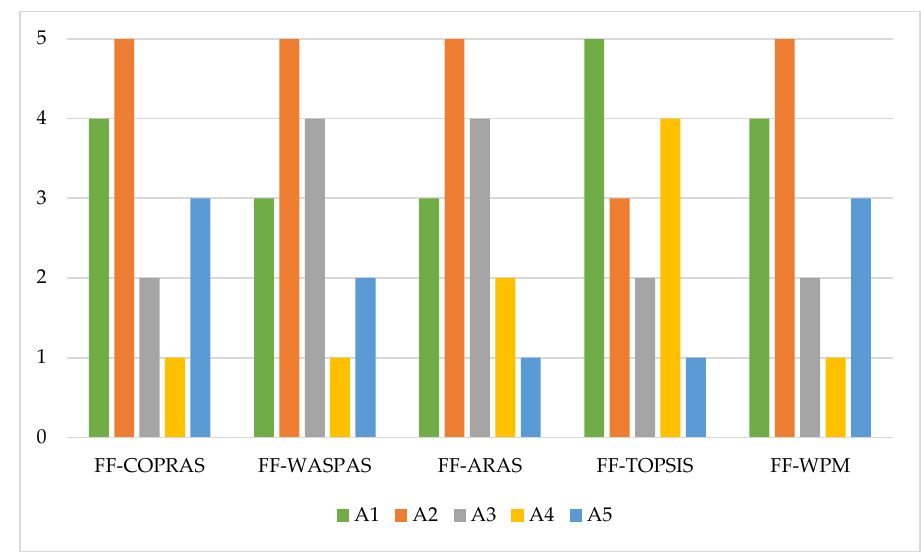
Figure 2. The ranking results obtained via different methods.